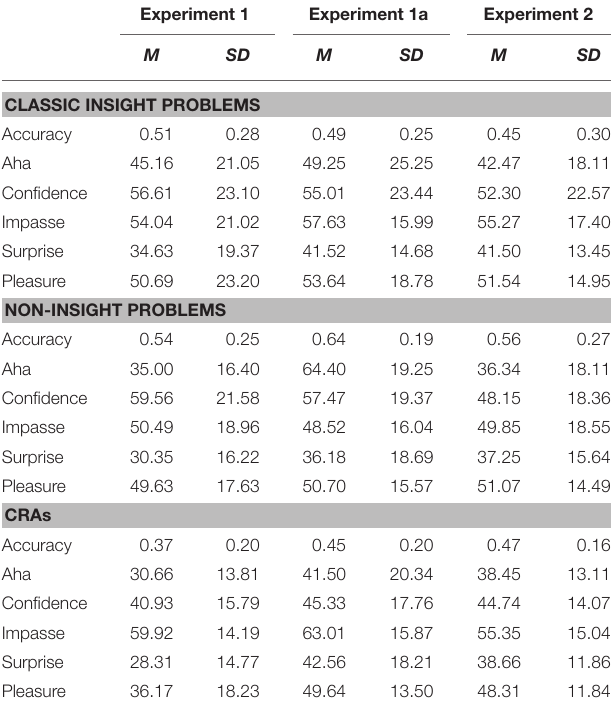
TABLE 1 | Means and standard deviations for accuracy and insight quale for classic insight and non-insight problems, and for compound remote associates